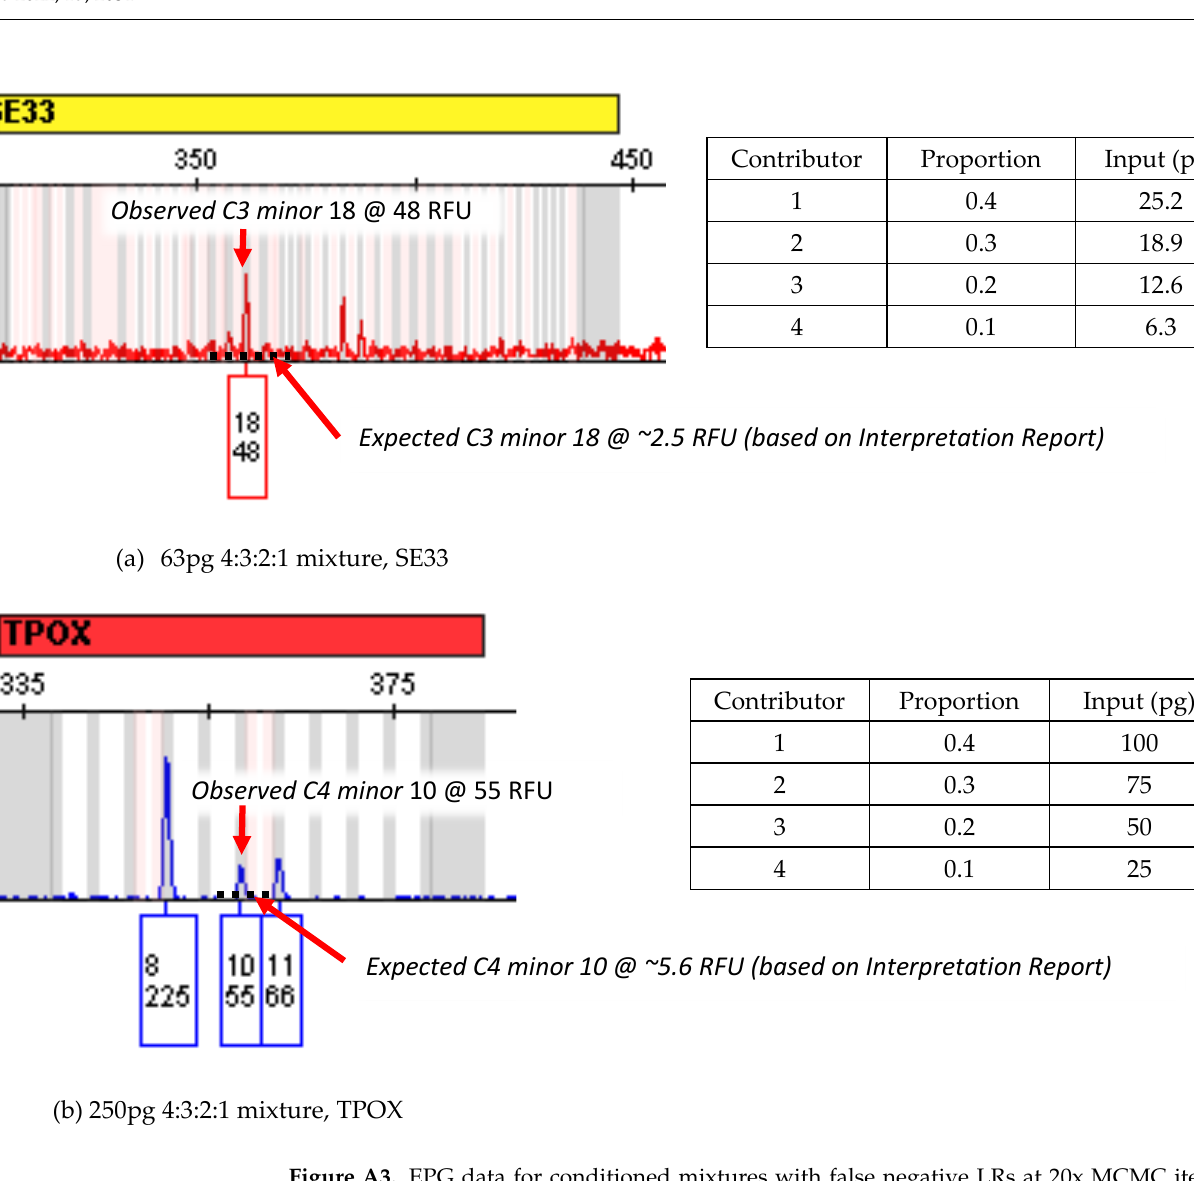
Figure A3. EPG data for conditioned mixtures with false negative LRs at 20x MCMC iterations. In both cases (see ( a , b ) below), unexpectedly high amplifications of peaks exclusive to one minor contributor at these loci led to incorrect inferences about peak sharing, which were exacerbated by conditioning. The black dotted line in each figure indicates the approximate expected height of the observed peak given exclusive attribution to the ground-truth contributor, based on per-contributor summary statistics in the STRmix Interpretation Report. This demonstrates visually why the software disfavored attributing the full height of each peak to its single true